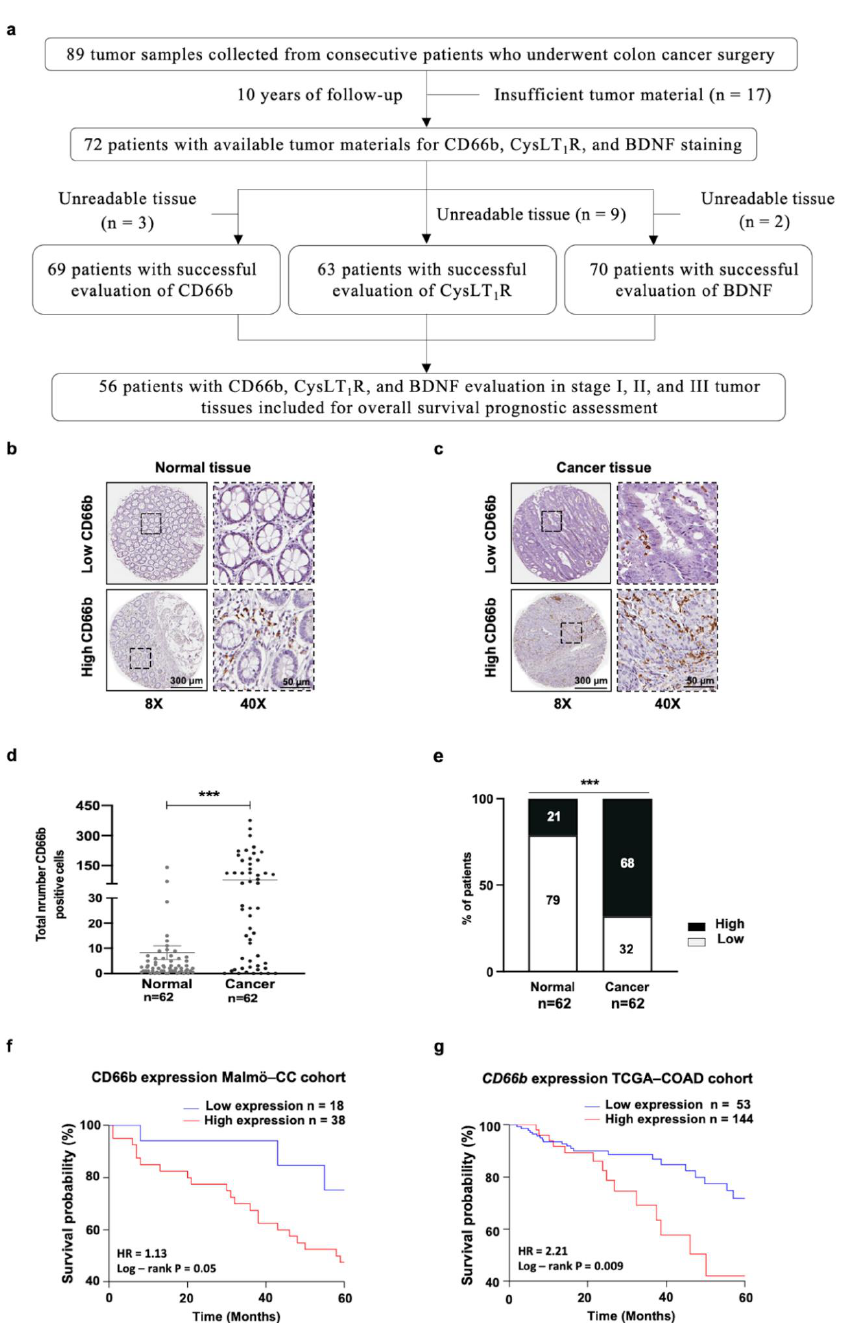
Figure 1. Elevation of tumor-infiltrating neutrophils in patients with colon cancer (CC). Tumor-infiltrated neutrophil valuation in tissue microarray of 72 patients with CC. ( a ) The flow chart of the study design, inclusion, and exclusion criteria. ( b , c ) Representative immunohistochemical staining of CD66b positive (CD66b + ) cells showing normal ( b ) and cancer ( c ) areas with low and high tumor infiltrated CD66b + neutrophils in matched normal (left) and cancerous tissue (right). Scale bars, 300 µm and 50 µm; 8× and 40× magnification. ( d ) Number of infiltrated neutrophils in normal and tumor tissue from patients with colon cancer. ( e ) Percentage of patients with low (<8) and high (≥8) tumor infiltrated neutrophil CD66b + cells. Kaplan–Meier analysis with the log-rank test of overall survival (OS) stratified for CD66b + cells in patients with colon cancer in Malmö CC cohort ( f ) and TCGA-COAD cohort ( g ) (cut-off based on the ROC-Youden Index). The results are shown as paired t -tests, ( d ) with the mean ± standard error of the mean (SEM), and ( e ) chi-square test. *** p < 0.001.